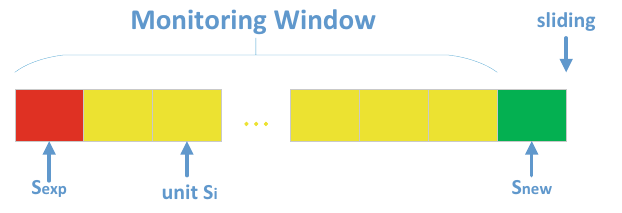
Fig. 3 Sliding window unit